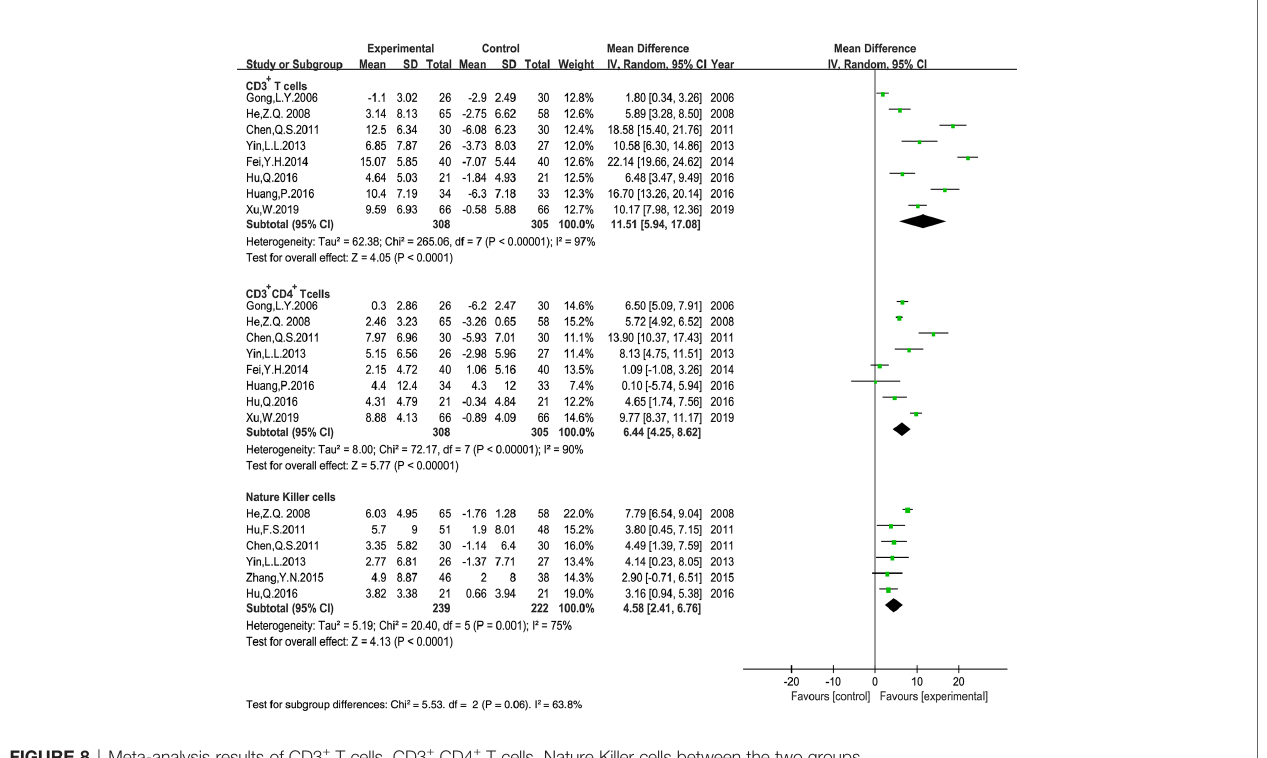
FIGURE 8 | Meta-analysis results of CD3 + T cells, CD3 + CD4 + T cells, Nature Killer cells between the two